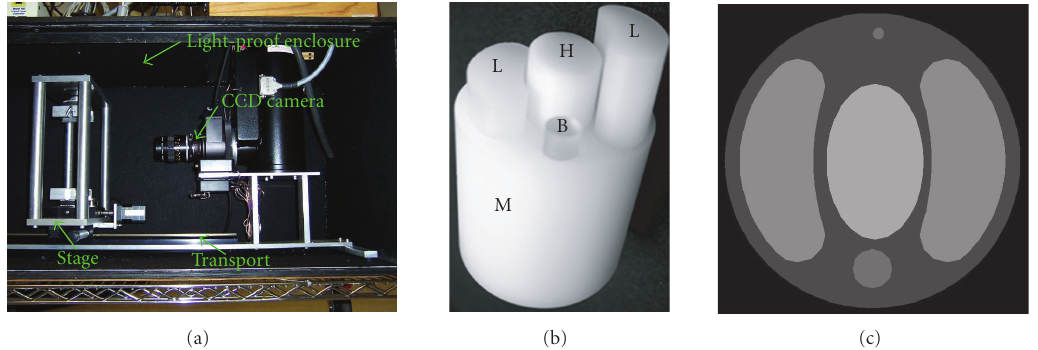
Figure 1: BLT system and physical phantom. (a) Multiview noncontact BLT prototype; (b) the physical heterogeneous phantom consisting of bone (B), heart (H), lungs (L), and muscle (M); and (c) a slice scanned by microCT scanner.